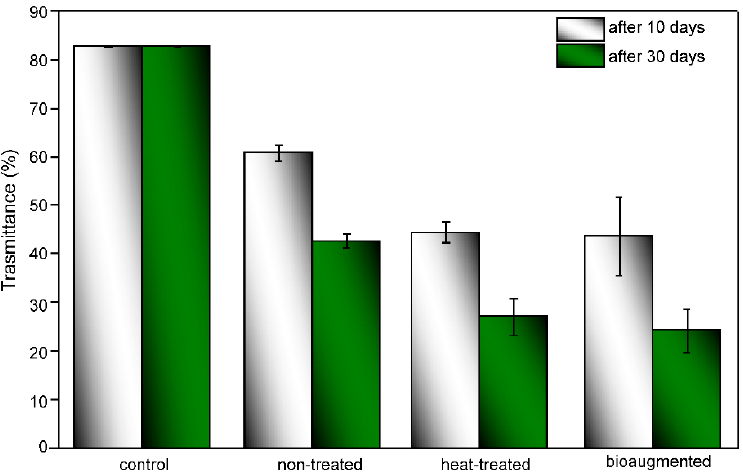
Figure 9. Changes in the % transmittance of the composted PVA/TPS films over time in the visible region from 200 to 400 nm.